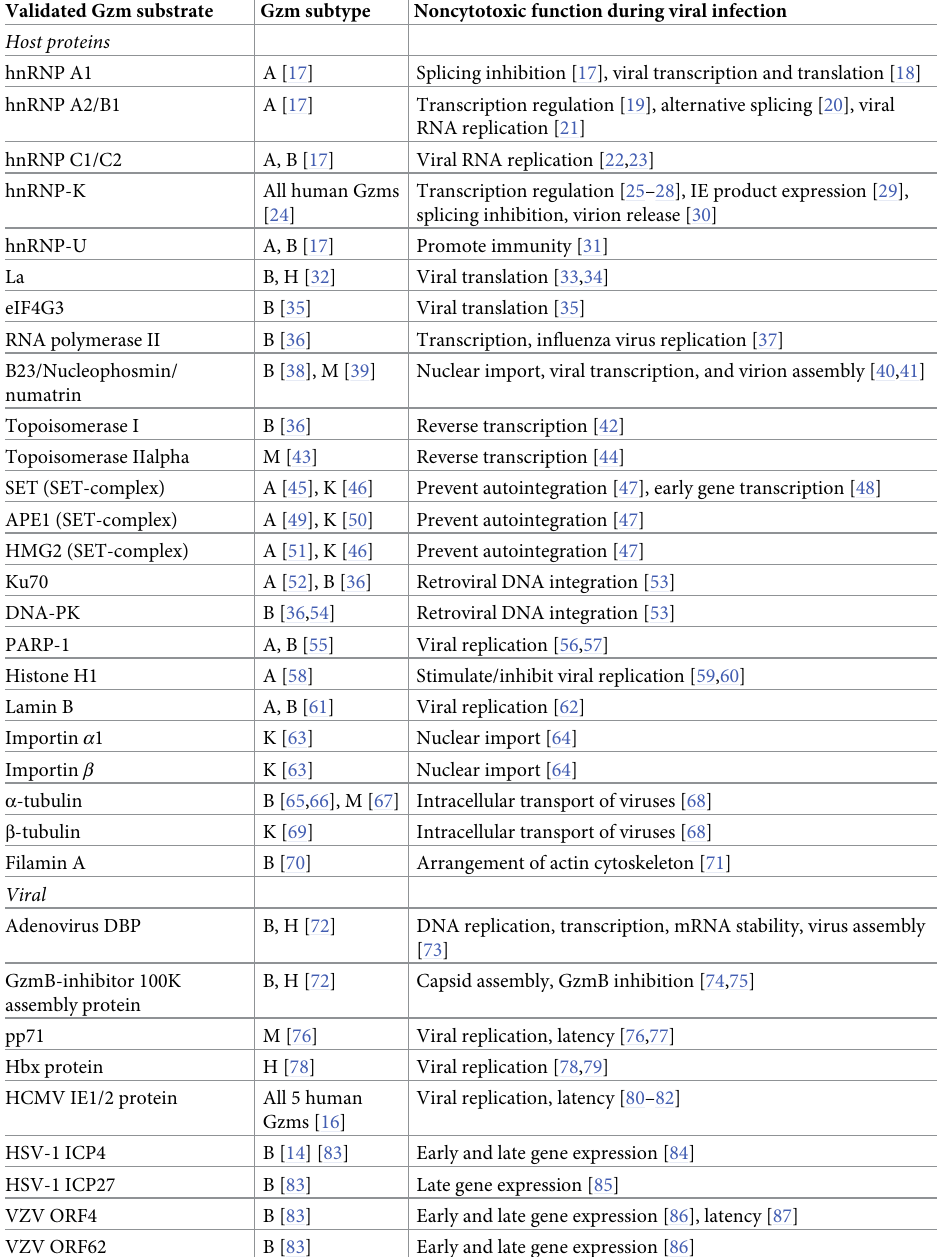
Table 1. Validated Gzm substrates affecting viral replication upon